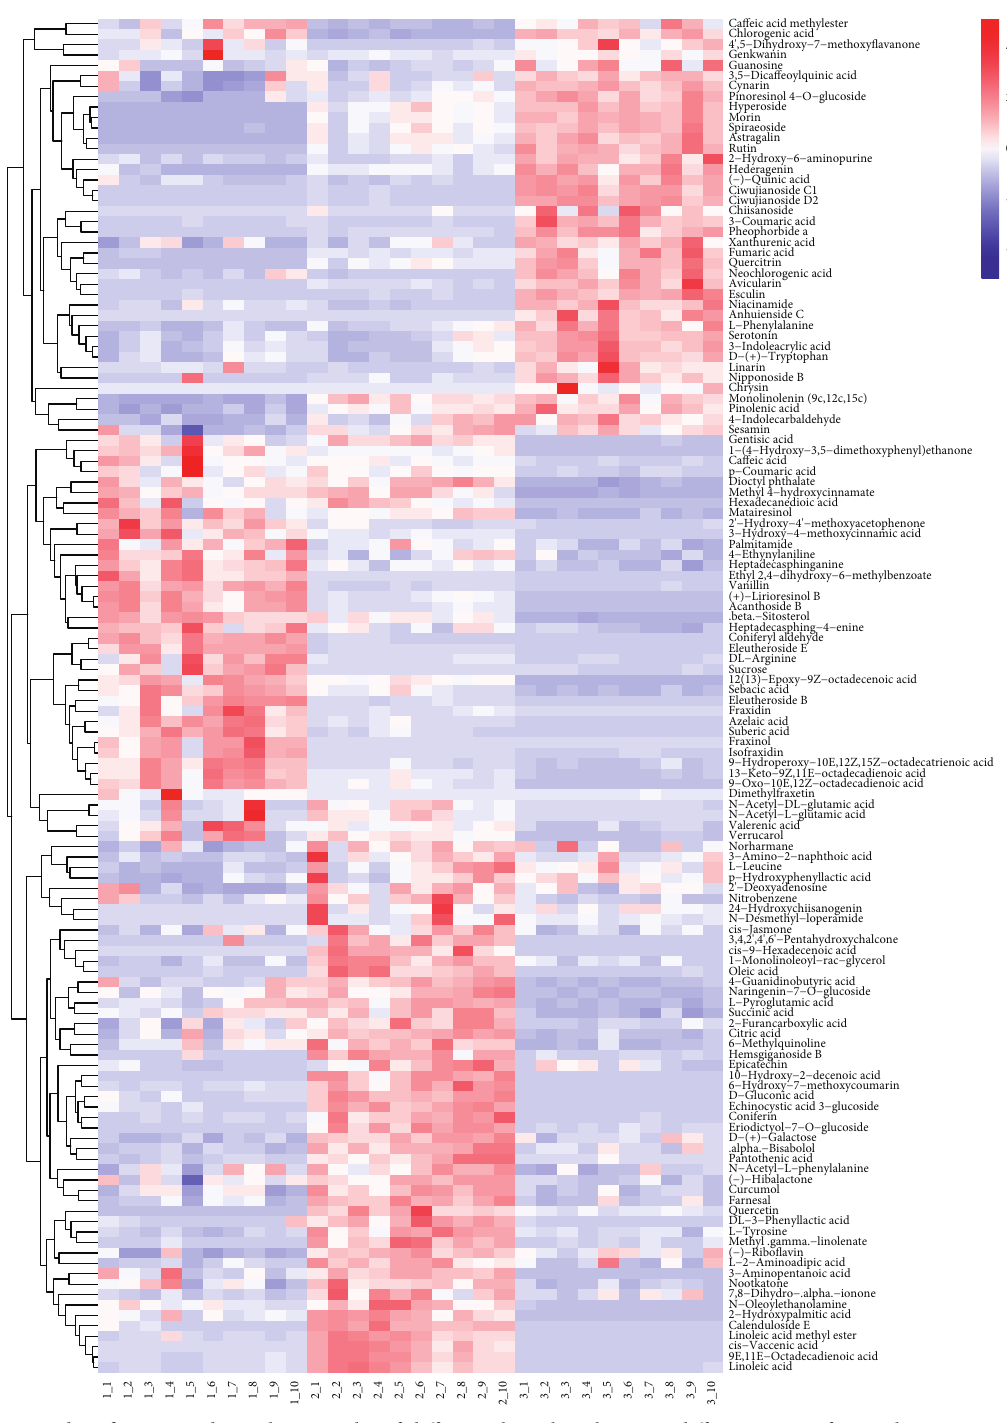
Figure 3: Identification and matching results of differential markers between different parts of Acanthopanax